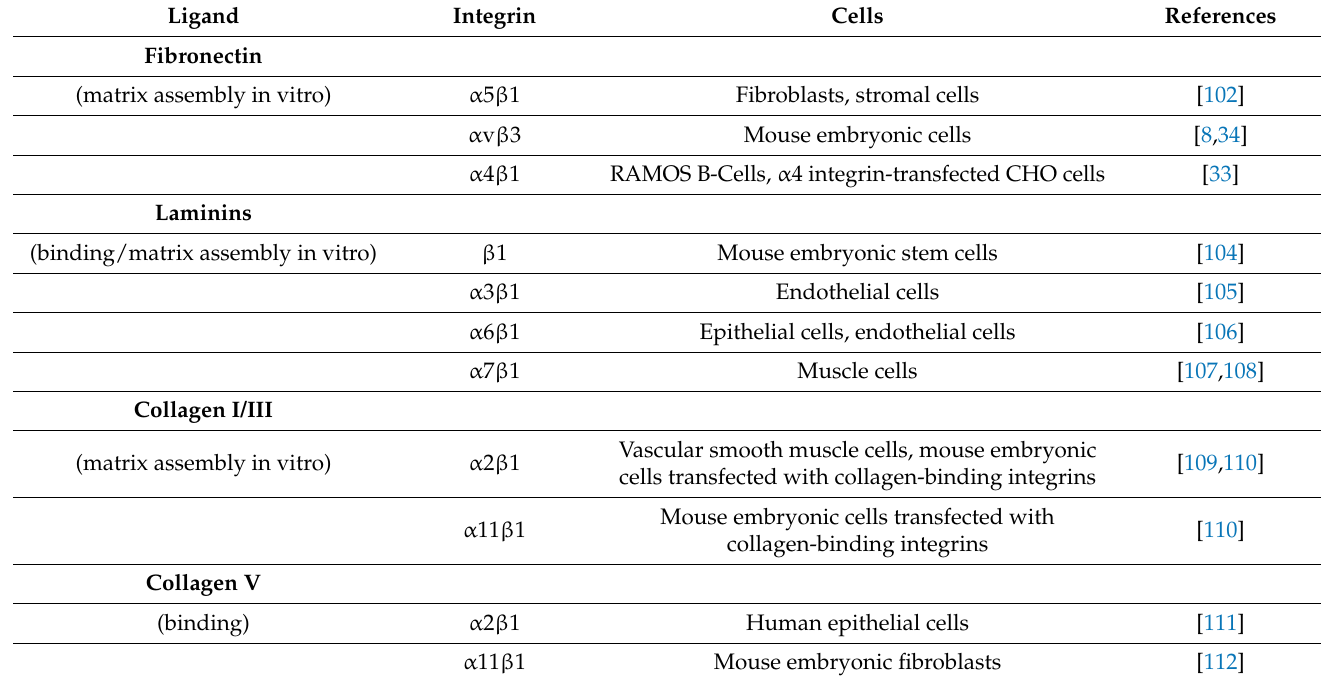
Table 2. Integrins Implicated in ECM Matrix